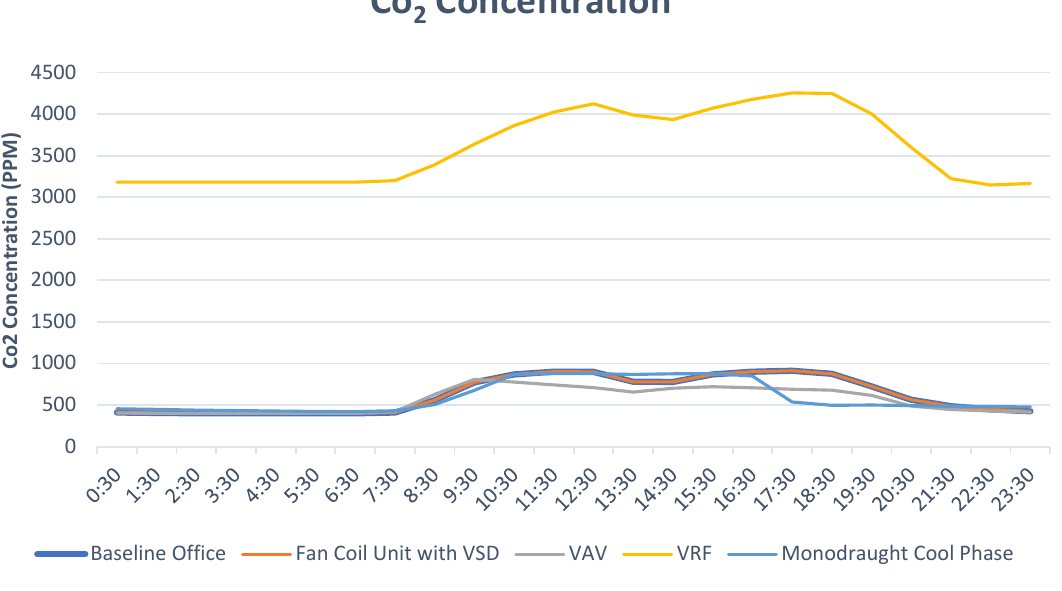
Table 16. Average Predicted Mean Vote (PMV) for different cooling systems.